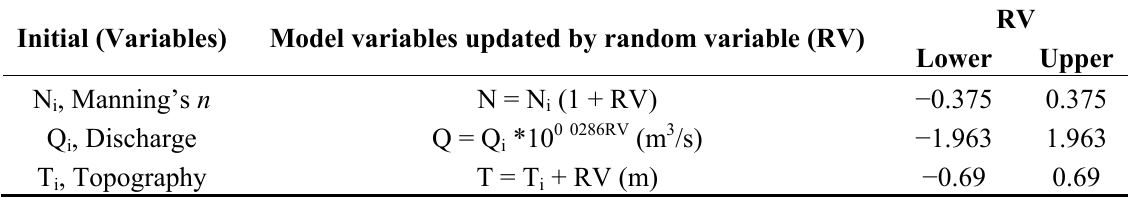
Table 2. The upper and lower boundary of the random variable (RV) for the parameters, where the units of RV are t-values with a 95% confidence interval for discharge and meters for topography. The unit of RV is dimensionless for Manning’s n